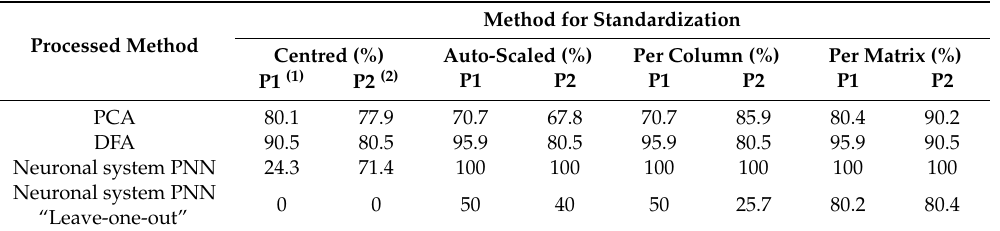
Table 4. Results of the methods of normalization and data processing.